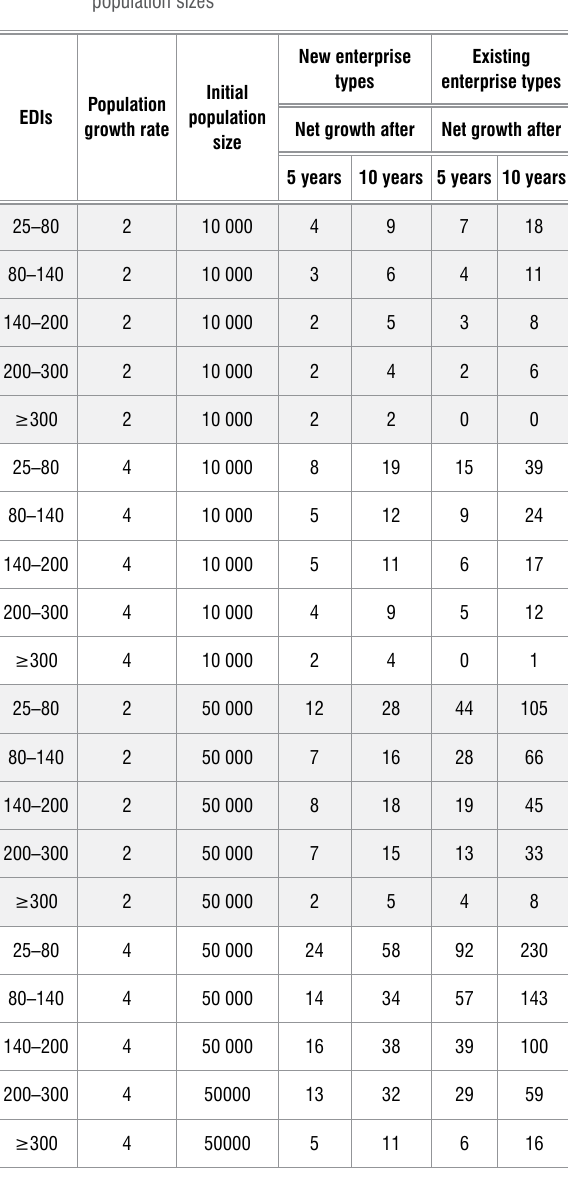
Projected net increases in total enterprises and enterprise types in South African towns subject to different growth rates and population sizes